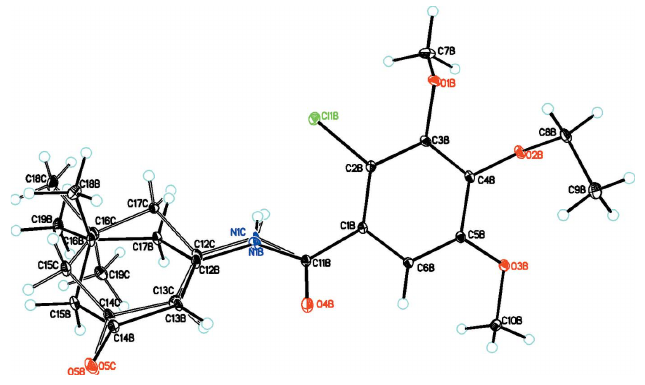
Figure 3 The molecular structure of the disordered molecule in 3b showing both disorder components ( 3bb and 3bc ) with atom labeling and with atomic displacement parameters shown at the 30% probability level.